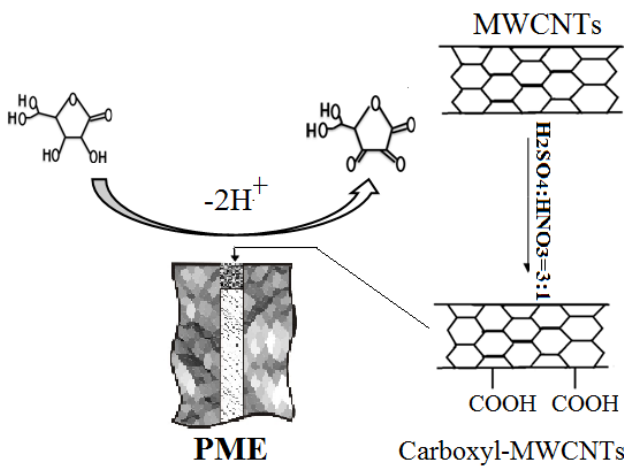
Figure 3. Working mechanism of PME for AA detection.